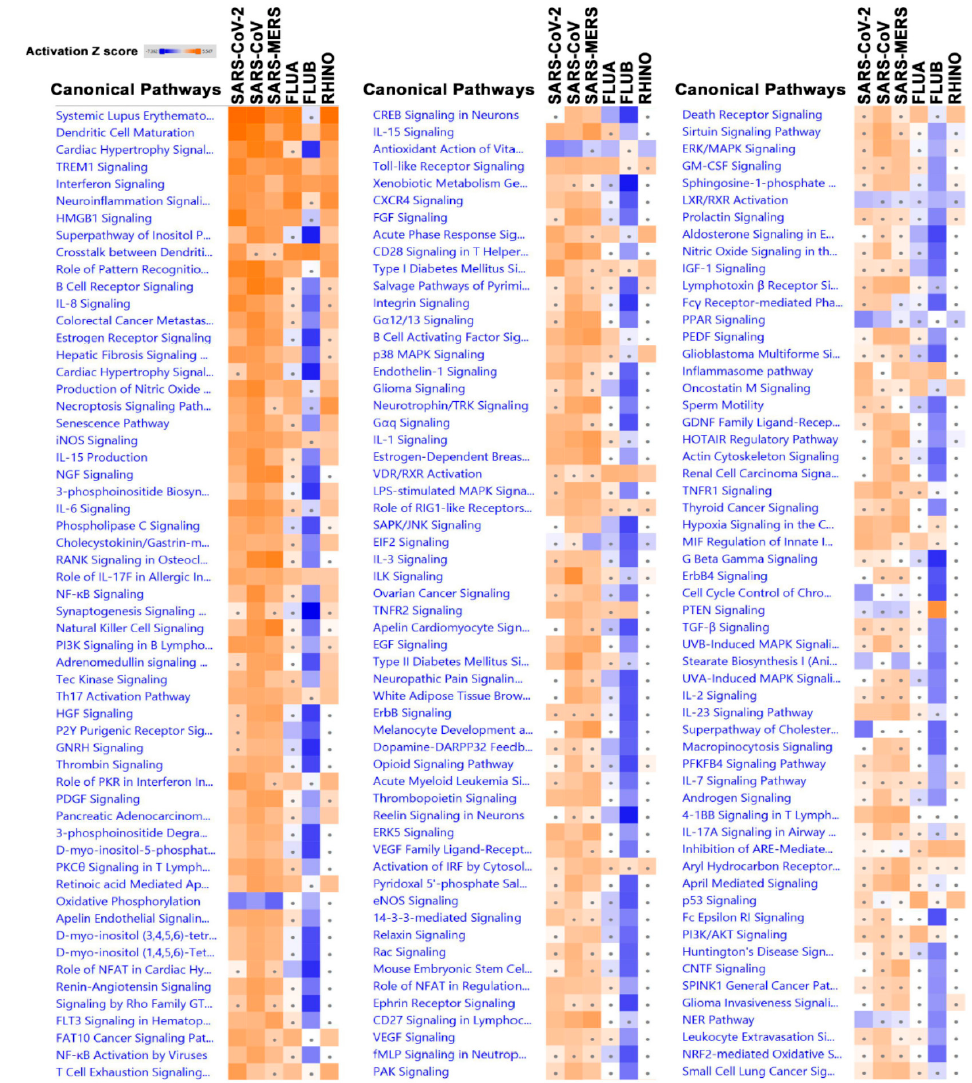
Figure 3. Significantly affected canonical pathways based on differentially expressed genes in the indicted treatment group (SARS-CoV-2, SARS-CoV, SARS-MERS, FLUA, FLUB, and RHINO) in Calu-3 cells. Differentially expressed genes from the six virally infected Calu-3 cells were subjected to canonical pathway analysis in ingenuity pathway analysis (IPA). Activation Z score is depicted according to the color scale (2.0 ≤ Z score ≤ − 2.0). Red indicated activation, while blue indicated suppression. Squares with a filled circle denote canonical with an absolute activation Z score < 2.0.